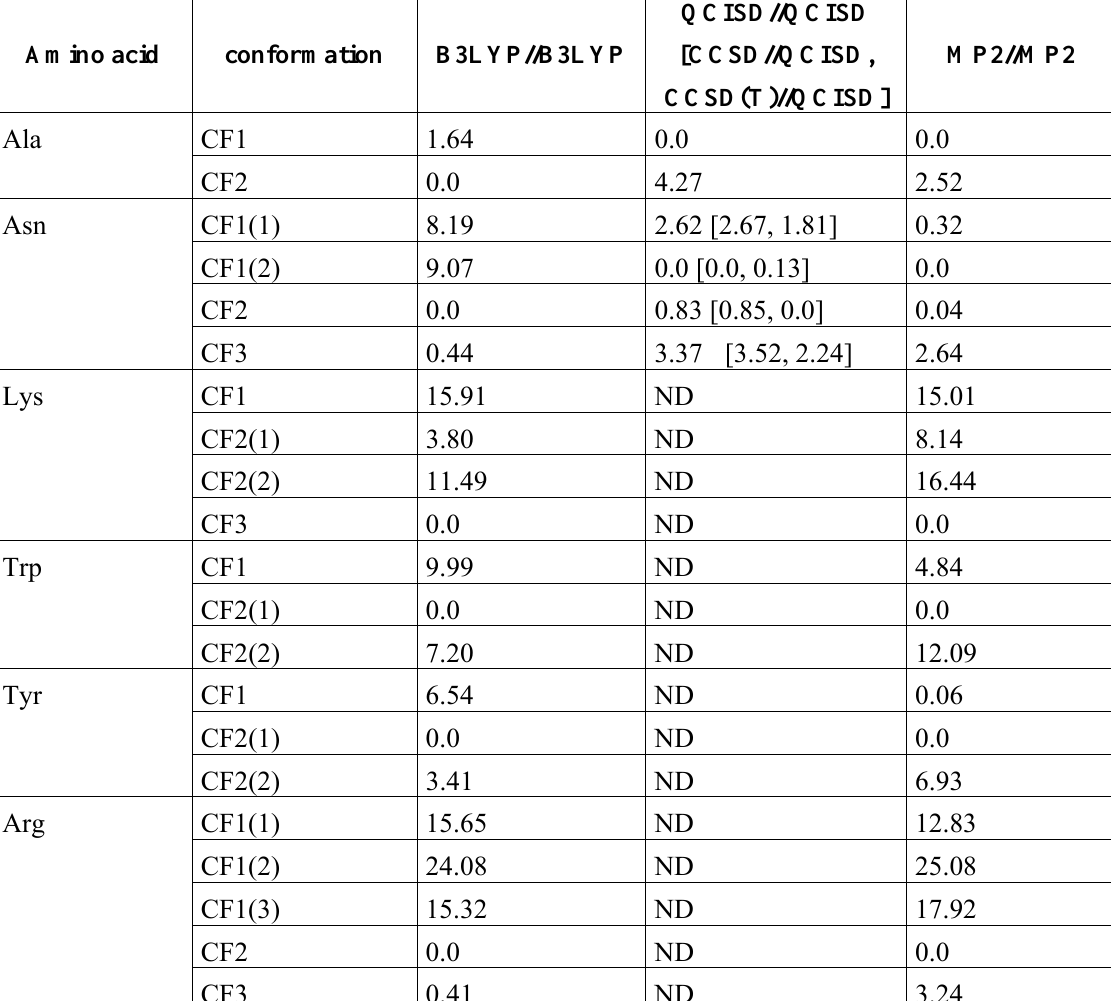
Table 1: Relative energies (kJ/mol) of few amino acid neutral conformations at three calculation levels: B3LYP, QCISD(FC) and MP2(FC). All the geometries are optimized at these respective levels. The basis set used throughout is 6-31G**. Only four results concern the CCSD//QCISD and CCSD(T)//QCISD levels, for Asn. The lowest energy conformation is the reference ( ∆ E=0.0) for each case. ND= not